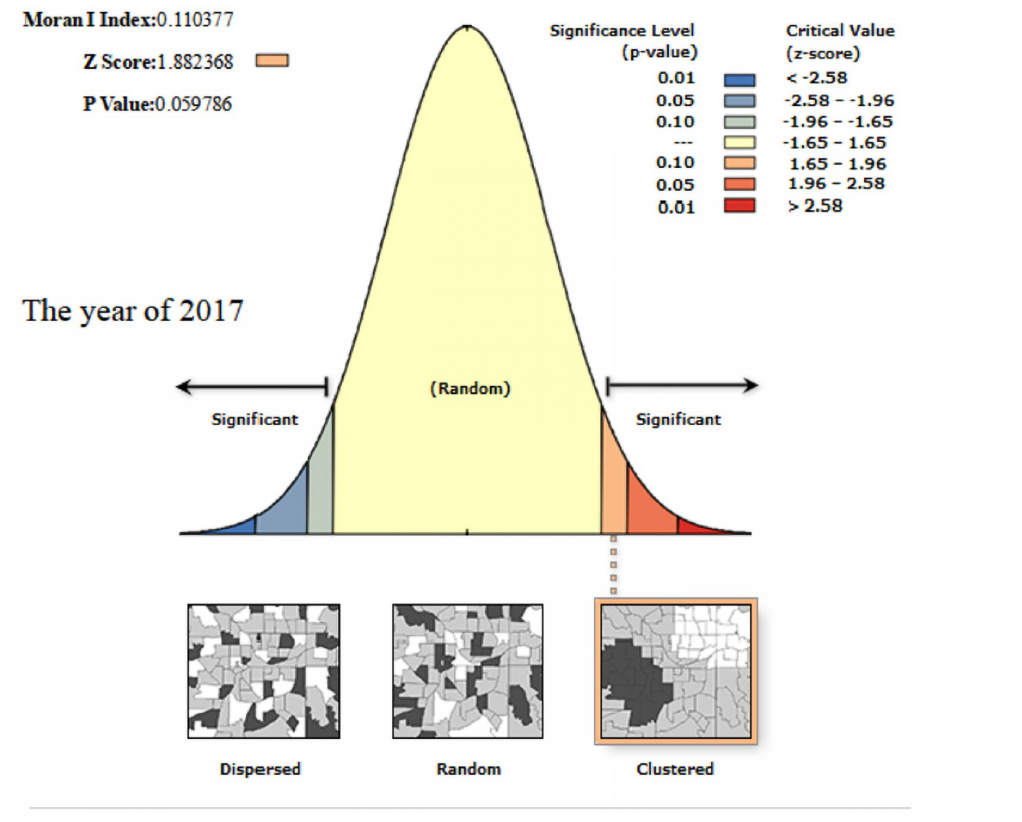
Fig 8. Spatial autocorrelation report of the coordination of the sports industry and health service industry of China in the year of 2017.